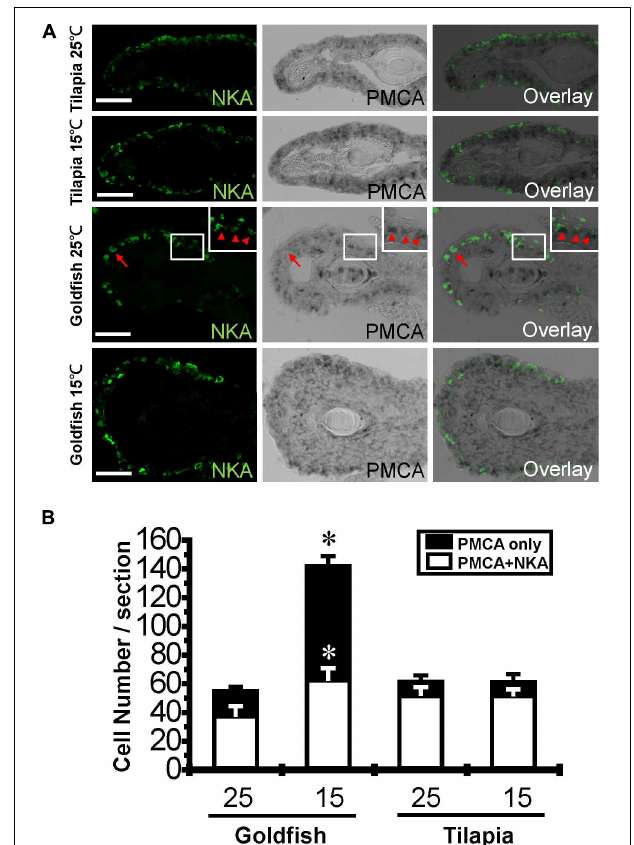
FIGURE 6 | Effect of cold acclimation on the Na + /K + -ATPase and PMCA-expressing ionocytes. Frozen sections of 25 ◦ C ( A , first row) and 15 ◦ C ( A , second row) acclimated tilapia, and 25 ◦ C ( A , third row) and 15 ◦ C ( A , fourth row) acclimated goldfish gills were stained with Na + /K + -ATPase (NKA) antibody and hybridized with PMCA RNA probes. Inset shows an enlarged picture of three co-stained cells. The numbers of PMCA only cells (arrow) or the double-stained (NKA/PMCA) cells (arrowhead) were averaged from three fish for each treatment ( n = 3) (B) . The cell numbers of three sections from different gill filaments of each fish are expressed as mean ± S.D. The means of control temperature (25 ◦ C) and cold-acclimated (15 ◦ C) groups from the same species were compared by Students’ t -test, ∗ p ≤ 0.05. Scale bar, 20 µ